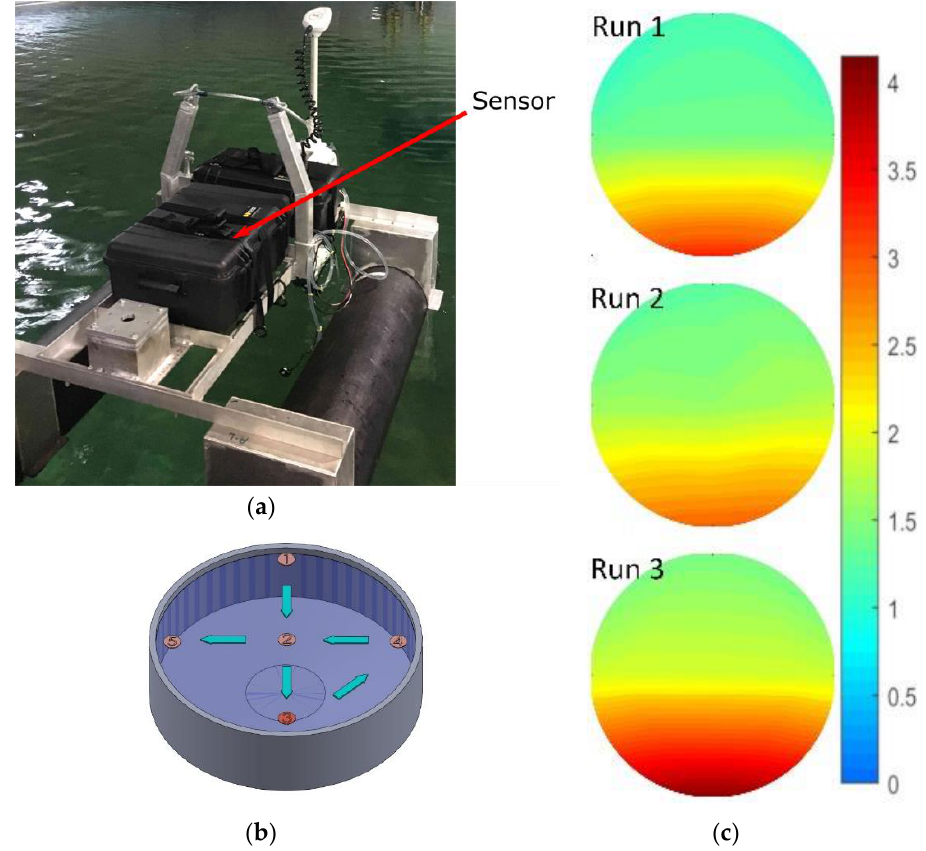
Figure 8. ( a ) Sensor in a water-tight case mounted to an unmanned surface vehicle in the Aquatron; ( b ) Aquatron CAD model with sampling points labeled. Nitrite dosing was done at point 3; ( c ) concentration mapping of three consecutive runs, scale units displayed are micromole.